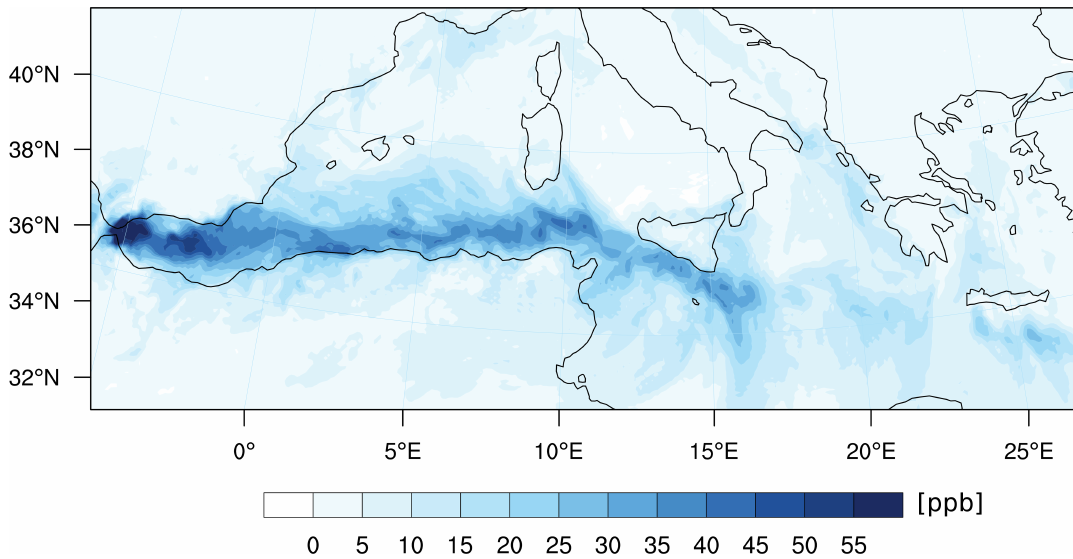
Figure 7. The difference (ppb) in the maximum O and No_ships simulations for the 2003 measurement